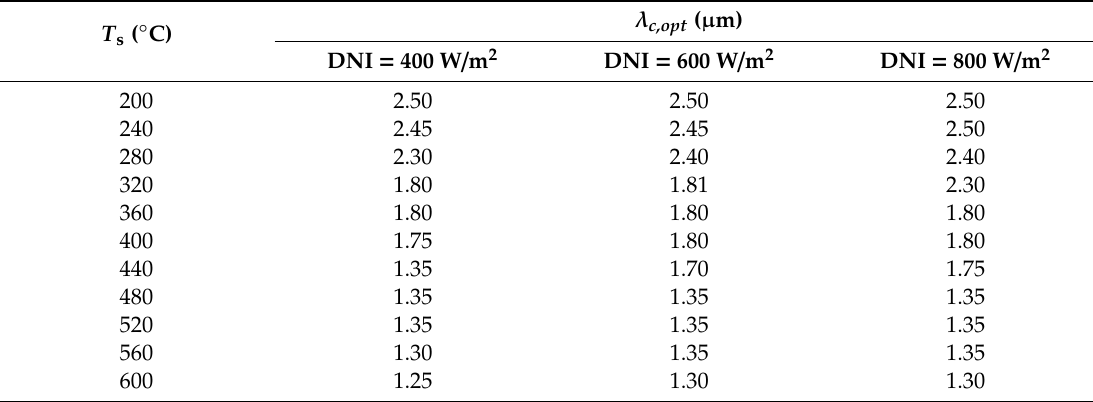
Table 1. Optimal cuto ff wavelengths under di ff erent values of direct normal irradiance (DNI) and absorber temperature.